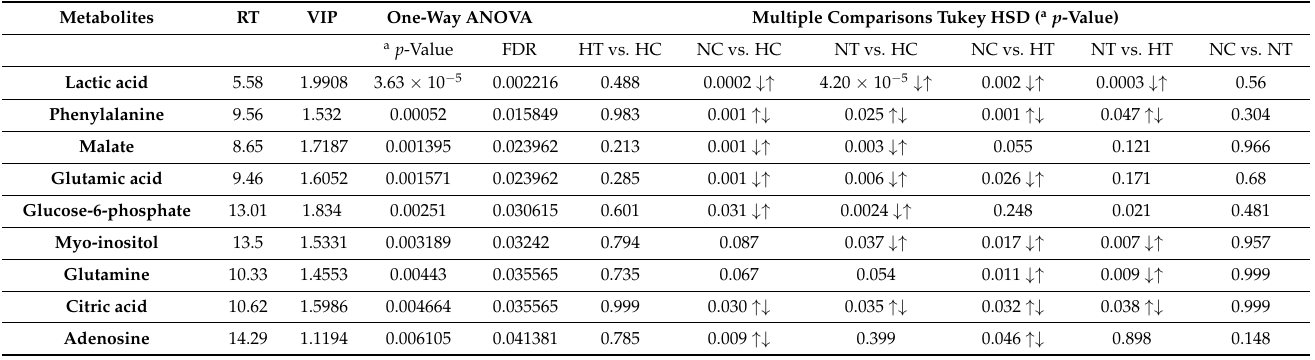
Table 1. Significantly altered metabolites among groups in normal and high ‐ glucose conditions with and without PEDF using a one ‐ way ANOVA and Tukey’s HSD tests .